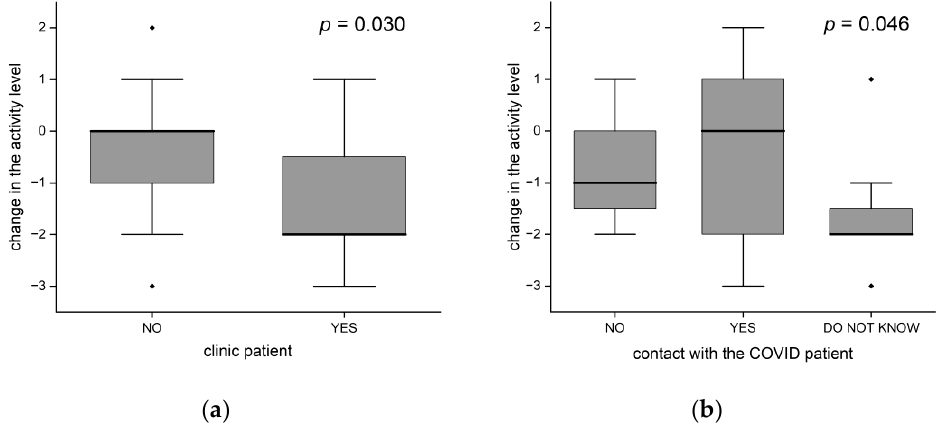
Figure 5. Changes in the level of activity ( a ) differences between clinic patients and others; ( b ) de- pends on exposure to COVID-19 (the black dots - outliers).